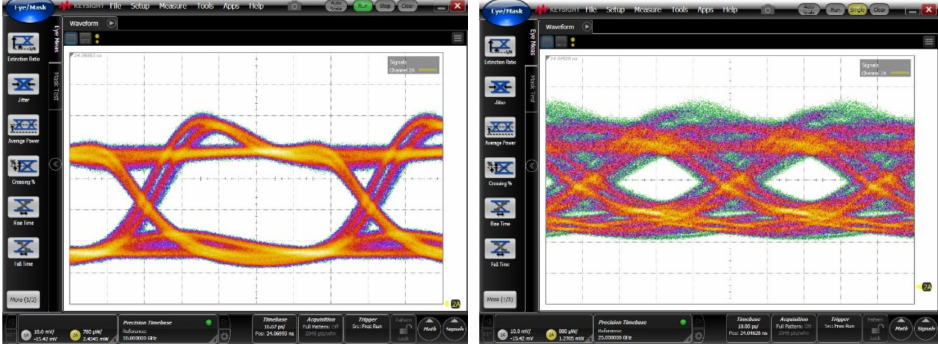
Figure 7. Eye diagrams at the modulation bit rates of 10 and 25 Gbit/s for